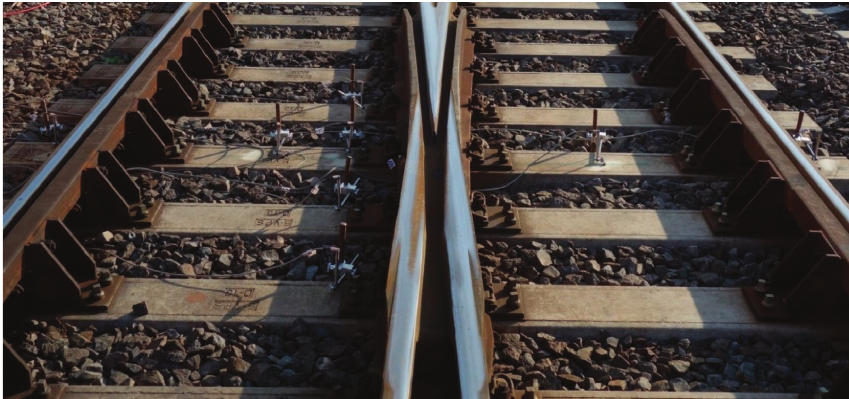
Figure 2: On-site installation of the sensors according to measurement methodology above.